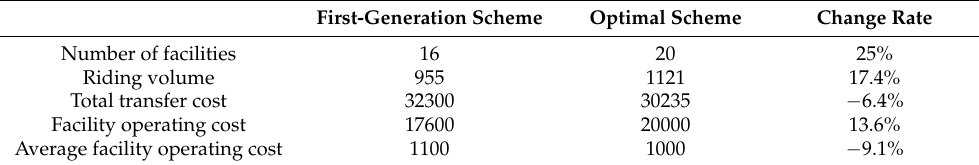
Table 5. Comparison of various indicators between the